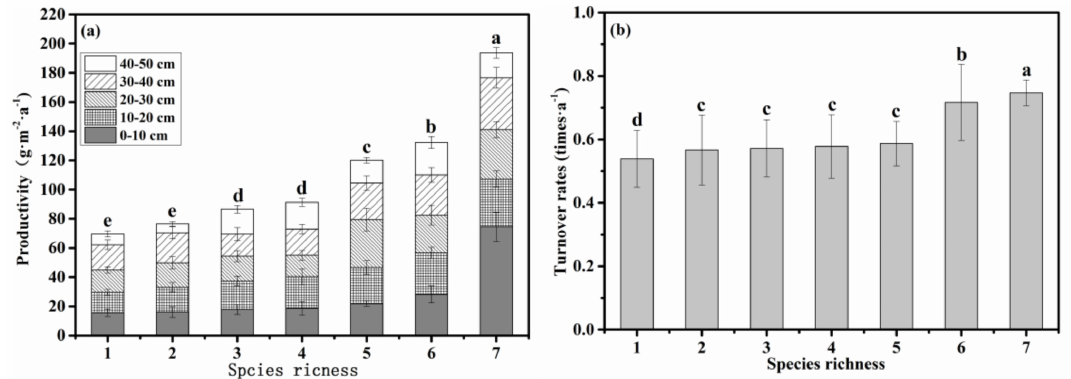
Figure 3. Fine root annual productivity and turnover rates in plant communities with different tree species richness. ( a ) Productivity; ( b ) Turnover rates; Note: different letters indicate significant differences, and the same letters indicate no significant difference ( p < 0.05).